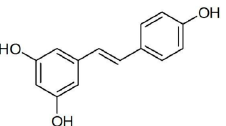
Figure 1. The chemical structure of Resveratrol (Res).